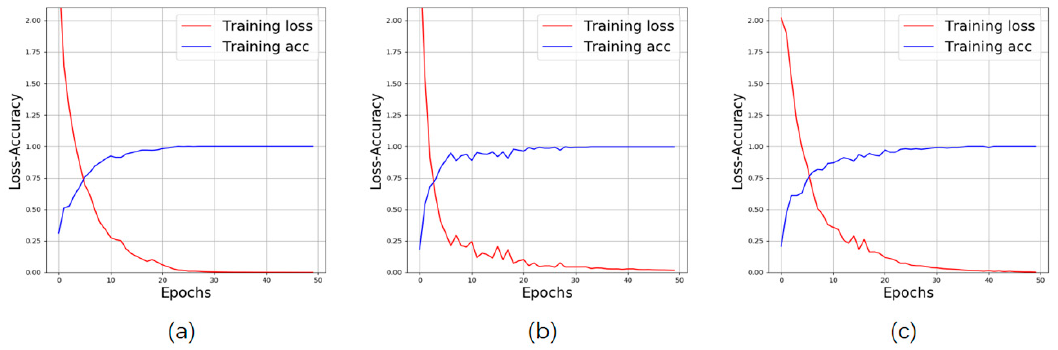
Figure 5. Training loss and accuracy convergence for ( a ) Indian Pine, ( b ) Salinas, and ( c ) Pavia University.